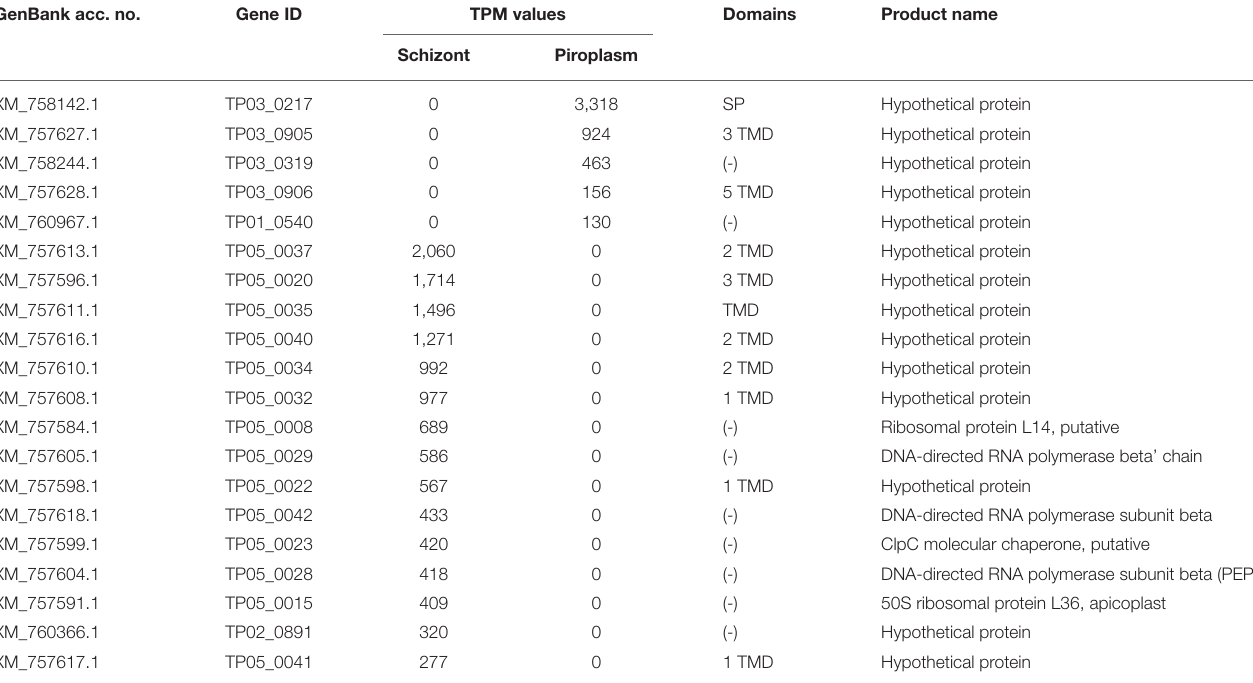
TABLE 2 | Top 20 highest expressed stage-specific genes. GenBank acc.